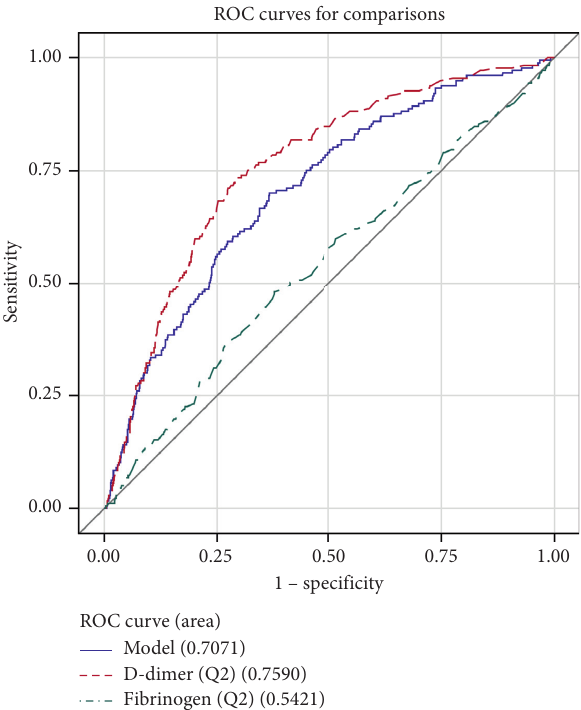
Figure 3: ROC curve for comparisons of D-dimer, fibrinogen, and combination of them in patients (45 < age ≤